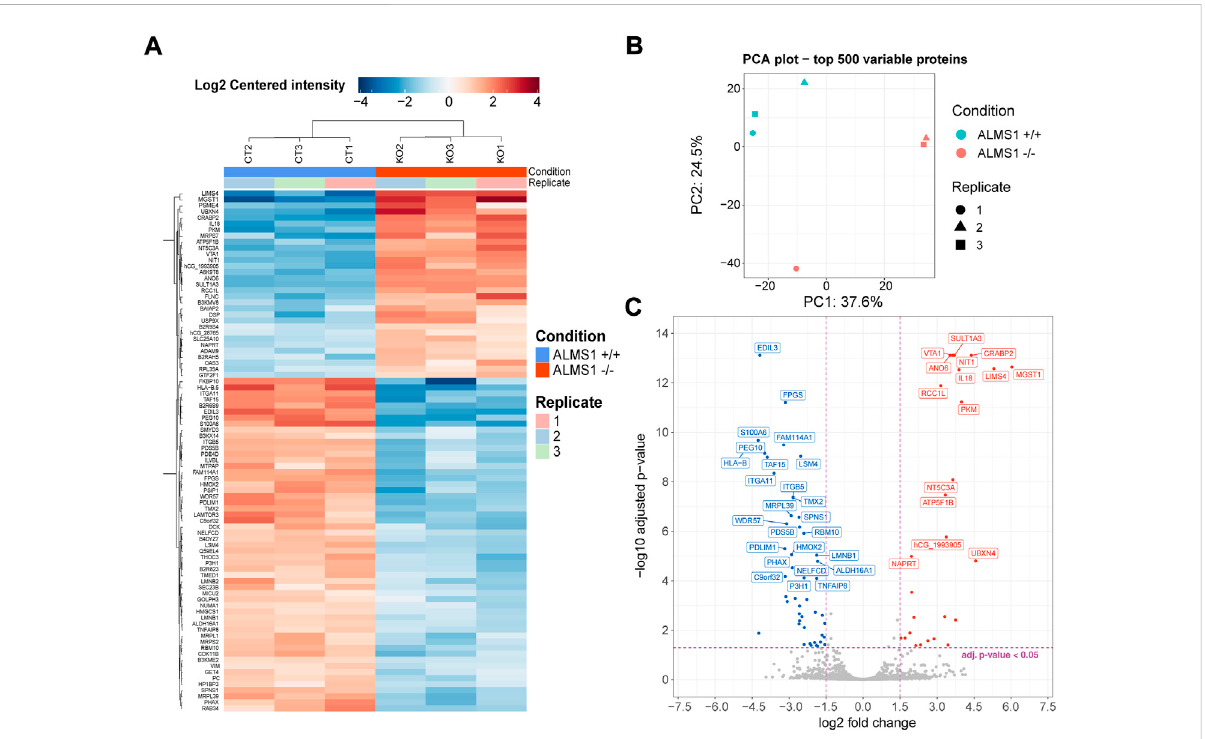
FIGURE 3 Differential expressionanalysisforproteomicdatainHeLa. (A) Heatmapforall proteins (associated andnot associated withgenes) differentially expressed. Plot shows the expression pattern for the 3 biological replicates of genotype ALMS1 +/+ (CT) and genotype ALMS1 − / − (KO). (B) Principal components analysis (PCA) for the top 500 variable proteins with all biological replicates for each genotype. (C) Volcano-plot showing the top